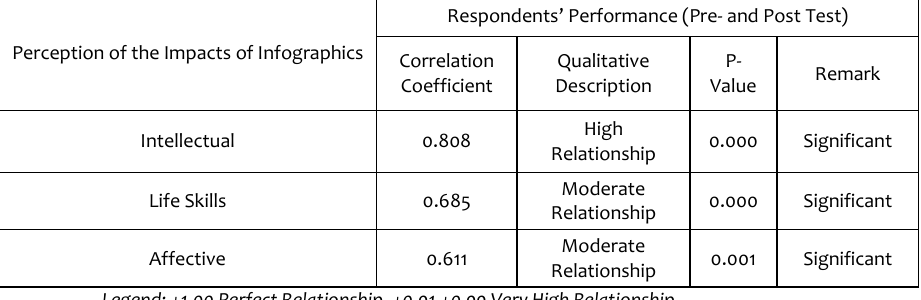
Table 6: Test of Significant Relationship Between Respondents’ Perception of the Impacts of Infographics and Their Pre- and Post-test Performance Respondents’ Performance (Pre- and Post Test) Perception of the Impacts of